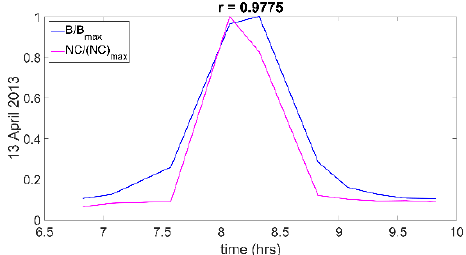
Figure 4. Hourly inter-comparisons of scattering coefficients under low relative humidity (RH < 20%) using the models’ NC/(NC) max and the instrumentation’s results (B/B max ) for 13 April 2013.